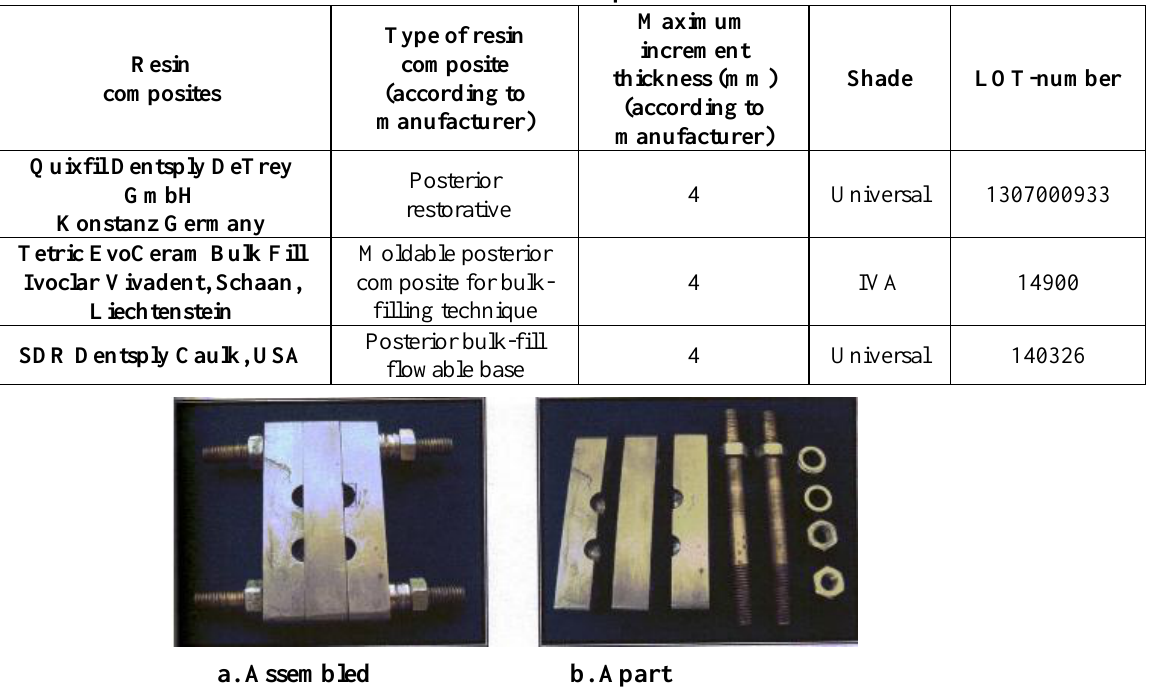
Figure 1: The Metal Mold Used in the Present